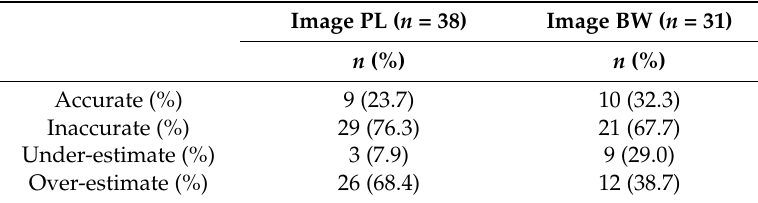
Table 5. Proportion of participants who accurately estimated portion size 1 .